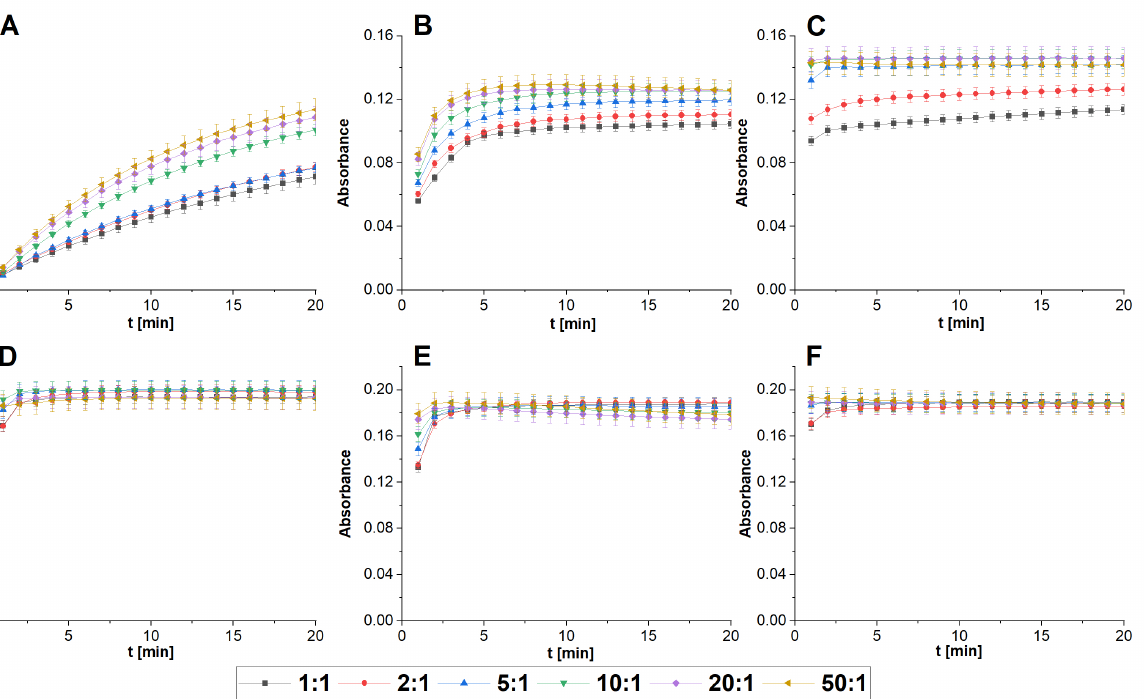
Figure 5. Complexation of Cu with porphyrins in a presence of AA at various [AA]:[Cu] ratios: ( A ) TSPP (pH 4); ( B ) TSPP (pH 7); ( C ) TSPP (pH 9); ( D ) TMPyP (pH 4); ( E ) TMPyP (pH 7); ( F ) TMPyP (pH 9). [Cu 2+ ] = [TSPP] = [TMPyP] = 10 −5 mol L −1 .